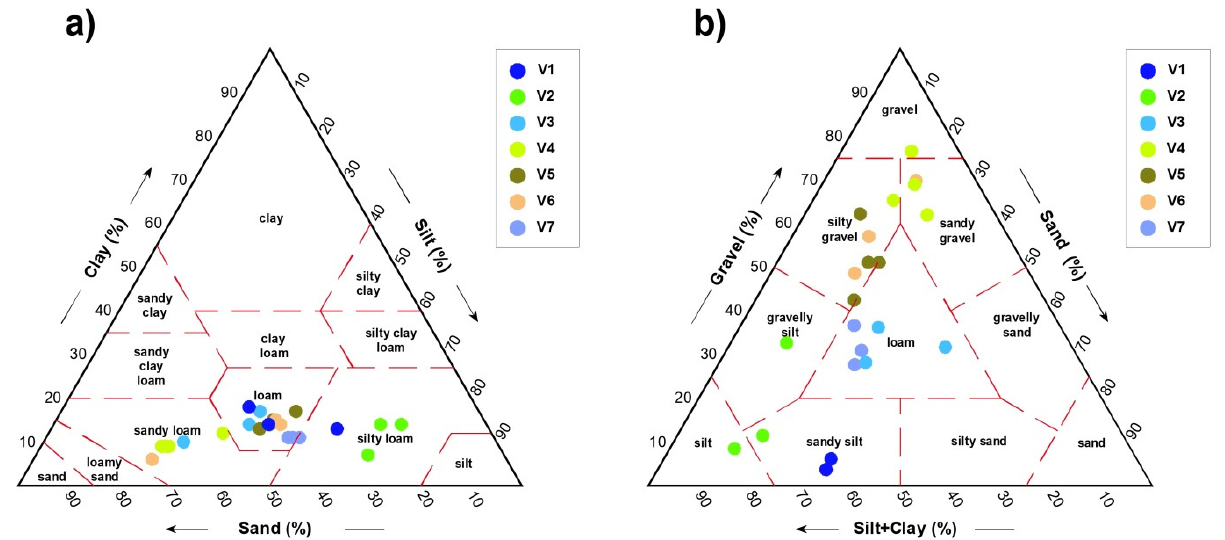
Figure 6. Soil and sediment classification schemes. ( a ) USDA soil texture triangle valid for fine earth, with particles less than 2 mm. ( b ) Modified Sheppard’s diagram (1954) for bulk soil texture, which best describes the studied soils, facilitating their classification and geographical delimitation of different terroirs. Note that the siliceous soils in V1, V3 and V7 are in the lower part of the diagram, and the mixed dolomitic soils in V4, V5 and V6 are in the higher part. V2 has undergone a specific sedimentary process driven by water flow and differs from other dolomitic soils.